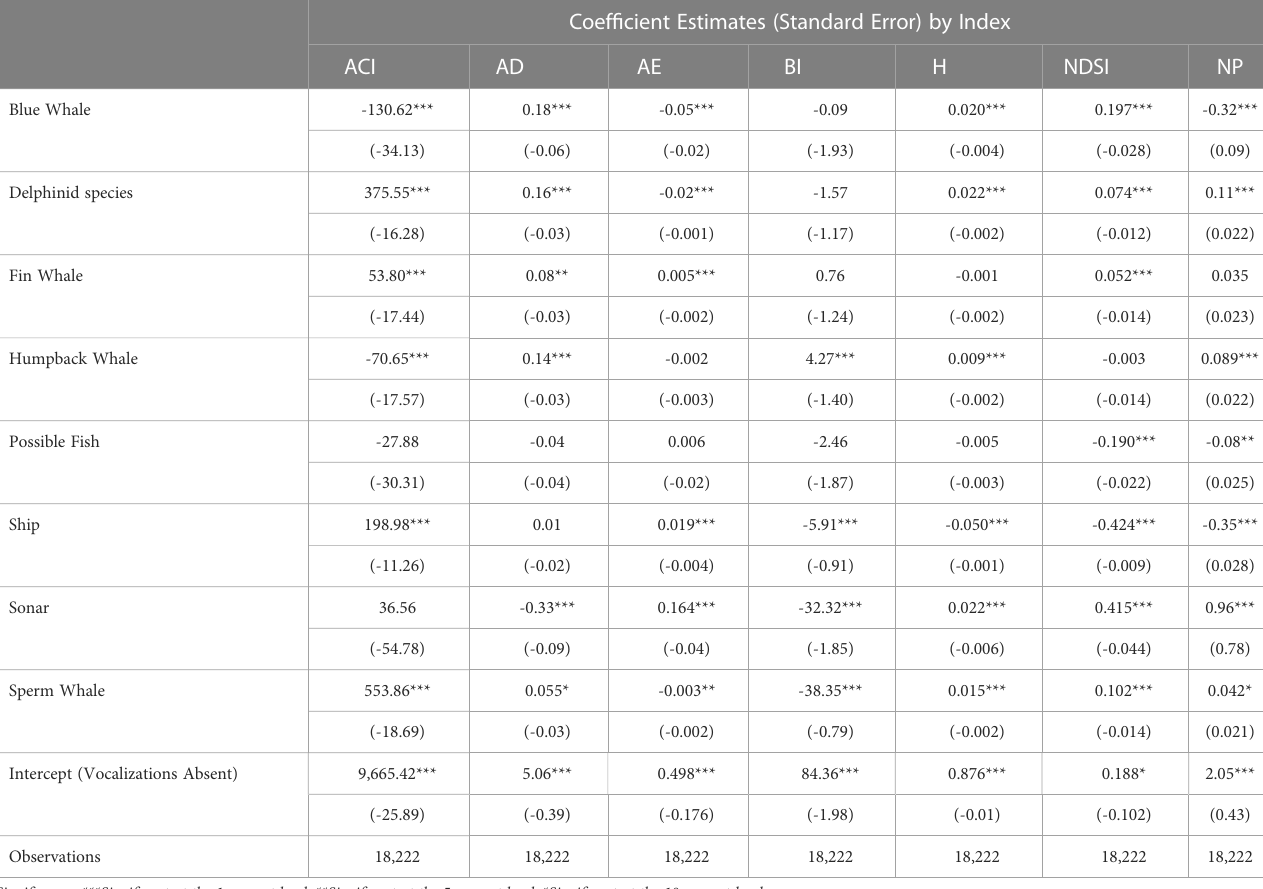
TABLE 2 Generalized linear mixed effects model evaluating the effects of species on each index incorporating recorder as a random